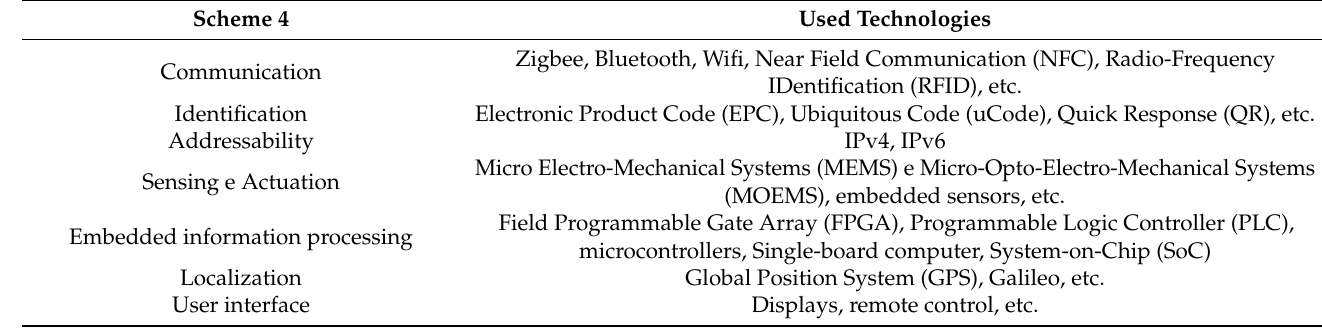
Table 1. Most used technologies in IoT